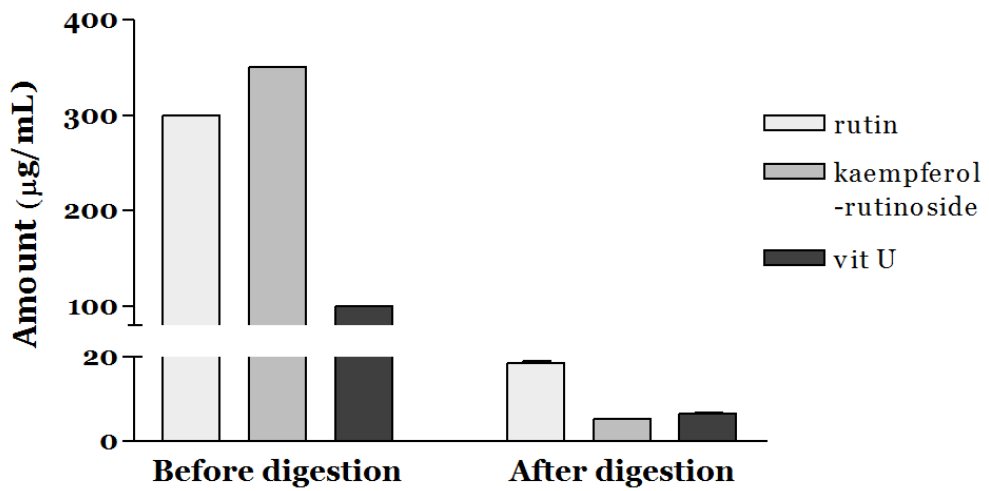
Figure 1. Bioaccessibility of bioactive components including rutin, kaempferol-rutinoside, and vitamin U (vit U) after simulated gastrointestinal digestion.